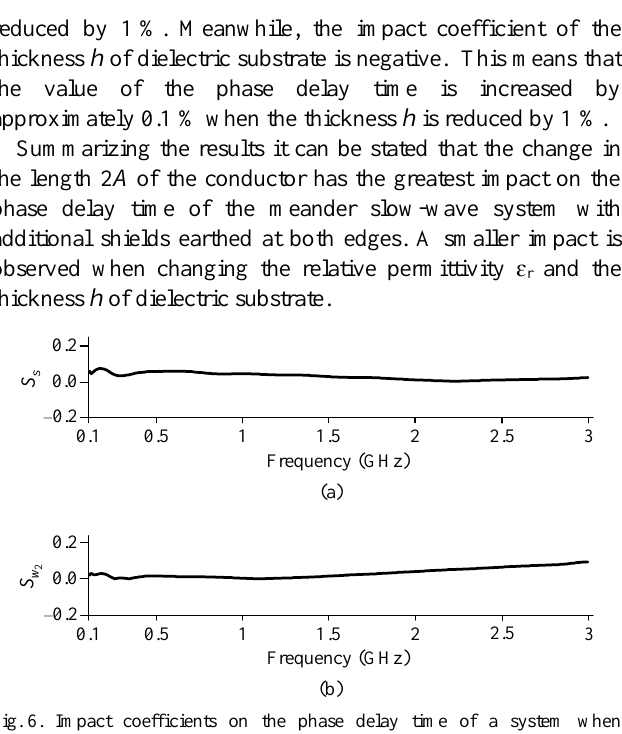
Fig. 5. Impact coefficients on the phase delay time of a system when changing: the length 2 A of meander conductor, and the width w 1 of meander conductor.